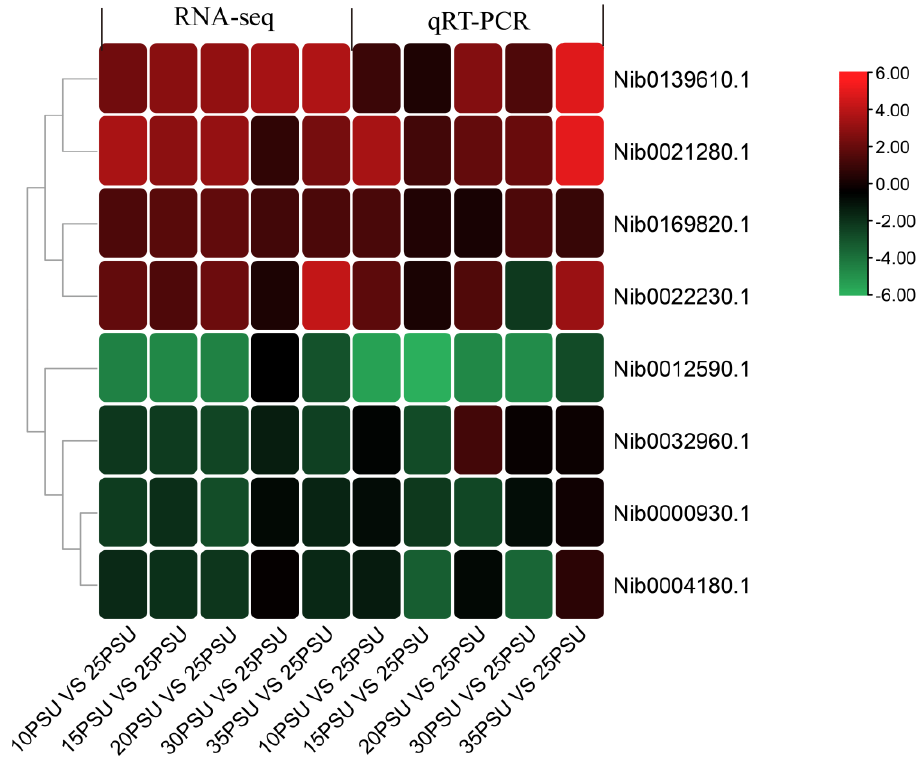
Figure 5. The relative change of the transcriptomes data and qRT-PCR data of eight